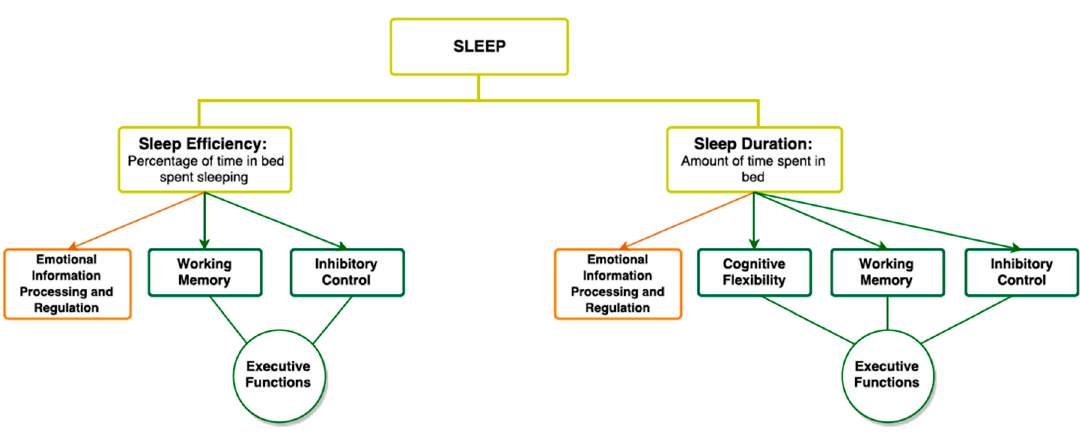
Figure 2. Conceptual framework demonstrating links between ToM and EF. The present chart demonstrates the links found in the literature between two sleep variables, the sleep efficiency (percentage of time in bed spent sleeping) and the sleep duration (amount of time spent in bed sleeping), and EF subtypes. Sleep duration is associated with cognitive flexibility [104], working memory [99,100,103], and inhibitory control [92–94,99]. Sleep efficiency is associated with working memory [102] and inhibitory control [97]. Both sleep duration and efficiency have been shown to be associated with emotional information processing and regulation